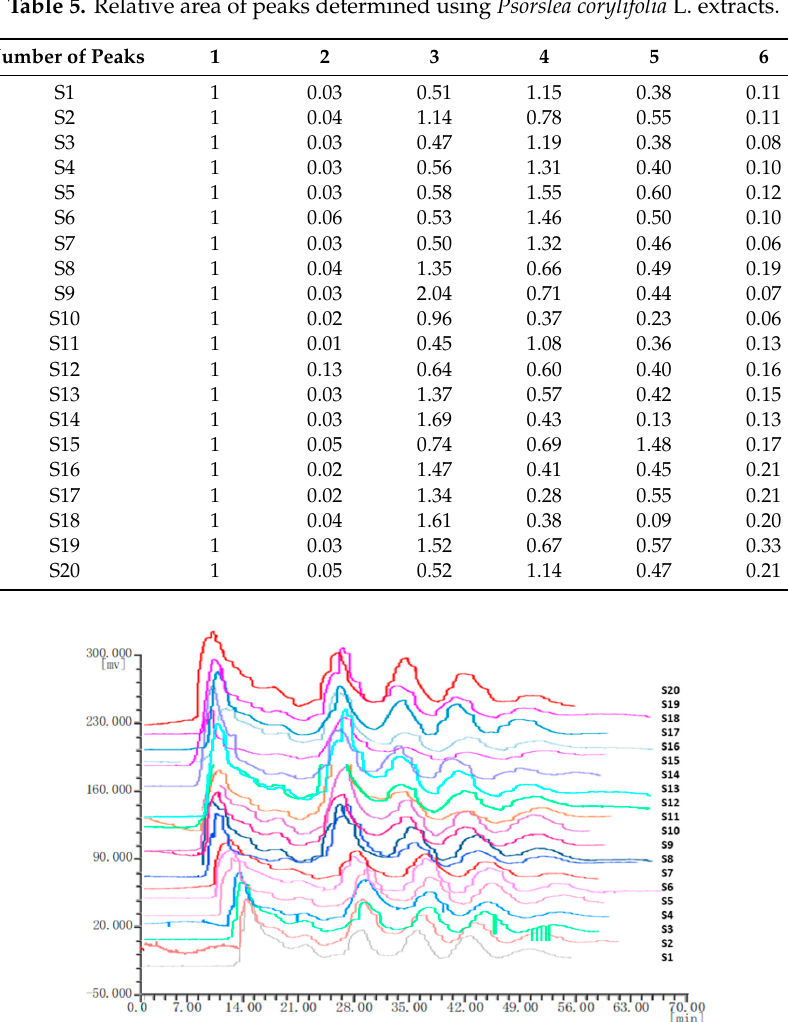
Table 5. Relative area of peaks determined using Psorslea corylifolia L. extracts.